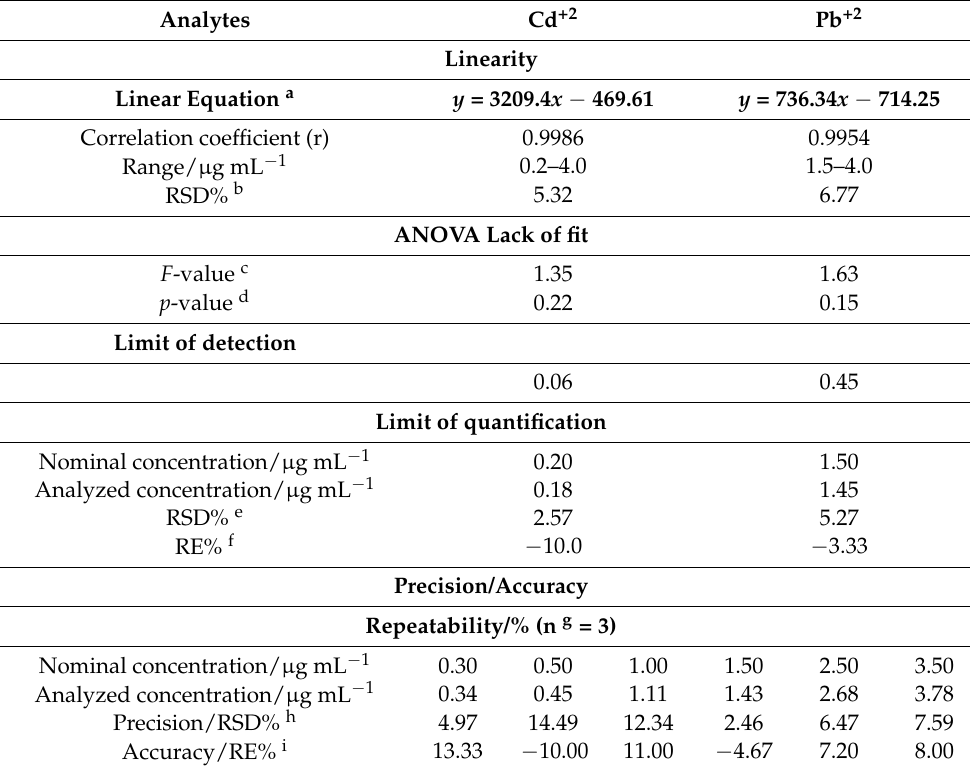
Table 3. Linearity, ANOVA lack of fit, limit of quantification, precision, and accuracy of Cd +2 and Pb +2 in Passiflora incarnata tea by the developed